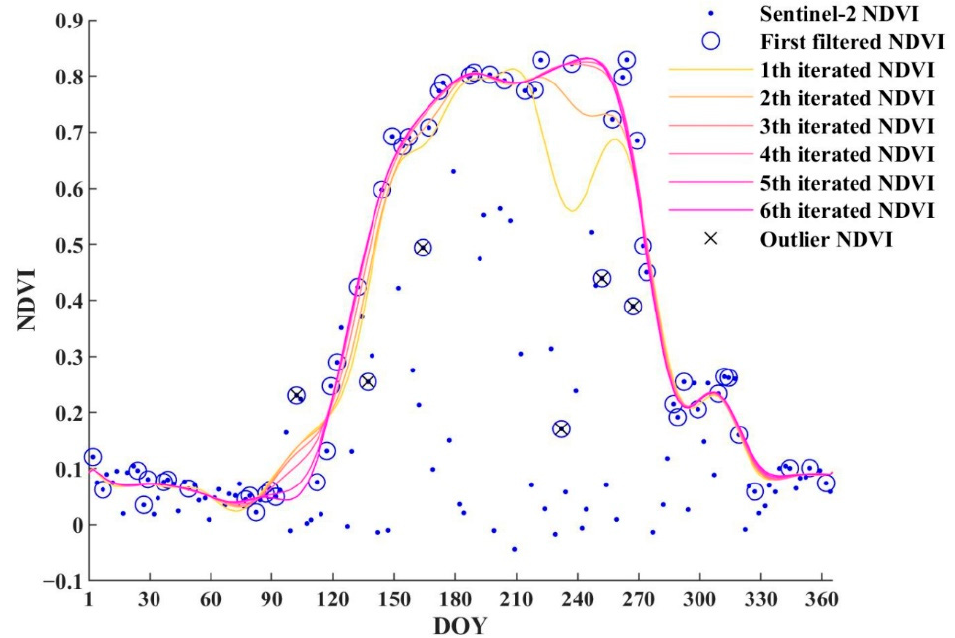
Figure 3. Iterative curve fitting process to update the weights for the NDVI time series of larch sample in 2020.